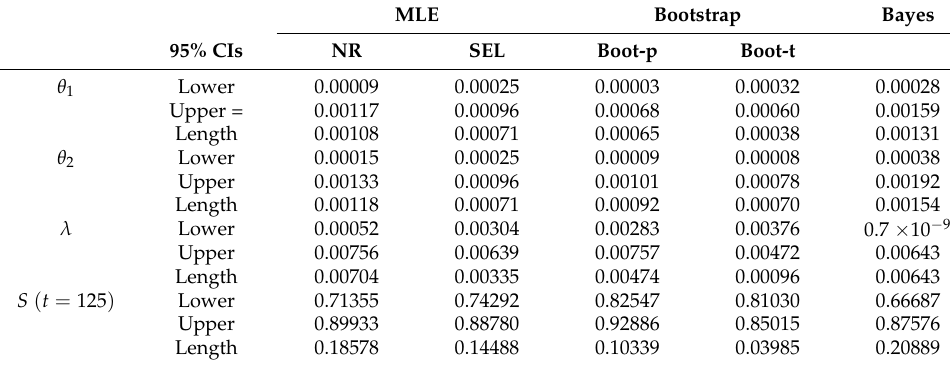
Table 7. 95% confidence intervals of θ 1 , θ 2 , λ , and S(t) for Xia et al. (2009)